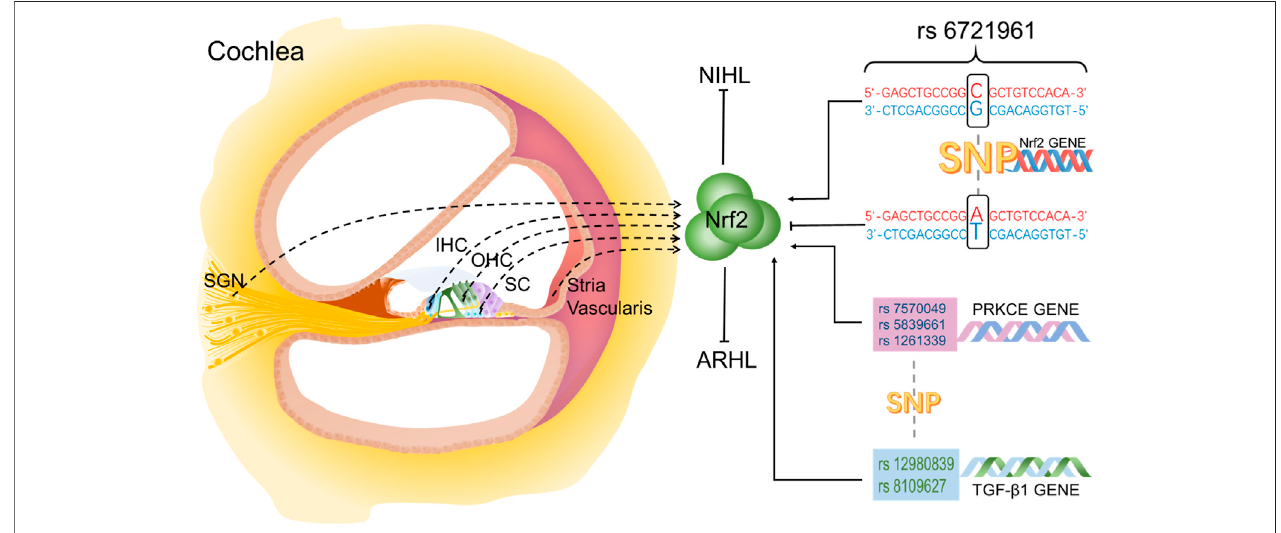
FIGURE 1 | Localization of Nrf2 in the inner ear and the effect of SNPs on Nrf2. Nrf2 is located in IHC, OHC, SC, SGN and stria vasculatures in cochlea.